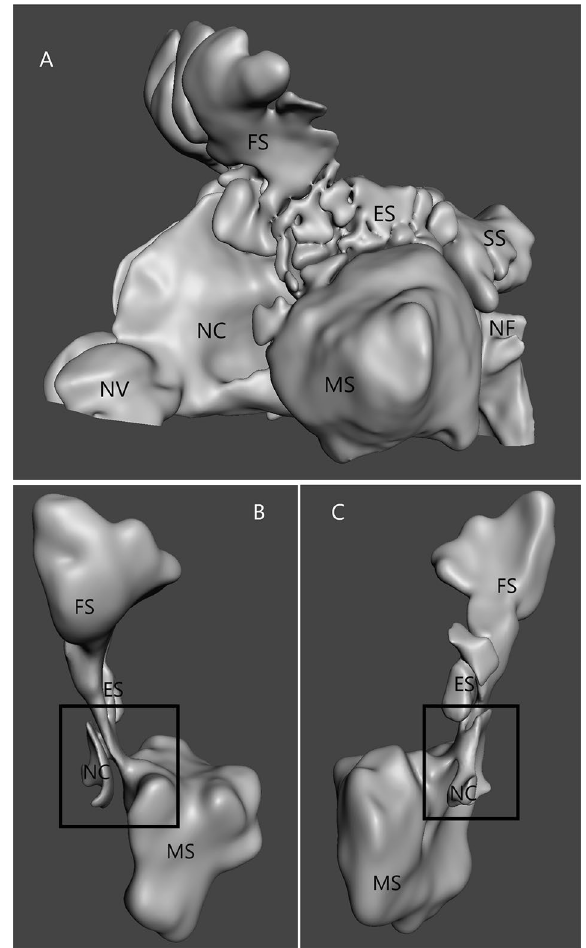
Figure 1. ( A ) 3D model of the nasal cavity (NC) and nasal sinus (ES—ethmoid sinus; MS—maxillar sinus; FS—frontal sinus; SS—sphenoid sinus; NV—nasal vestibule); ( B ) isolated the left ostiomeatal complex (black quad) region, anterior view; ( C ) isolated the left ostiomeatal complex (black square) region, posteromedial